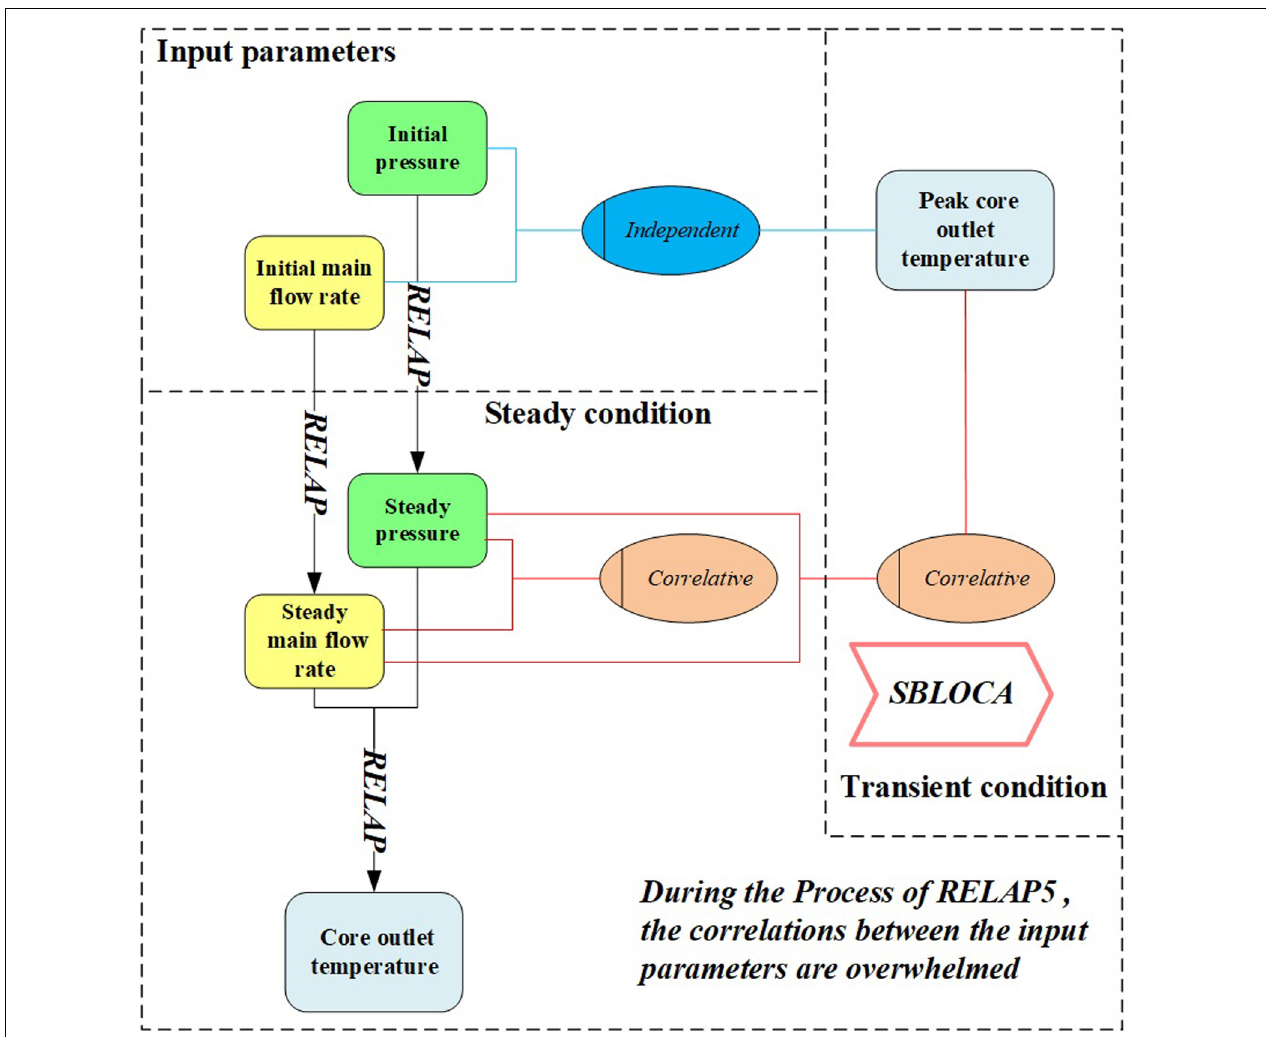
FIGURE 10 | The improved sensitivity analysis process.